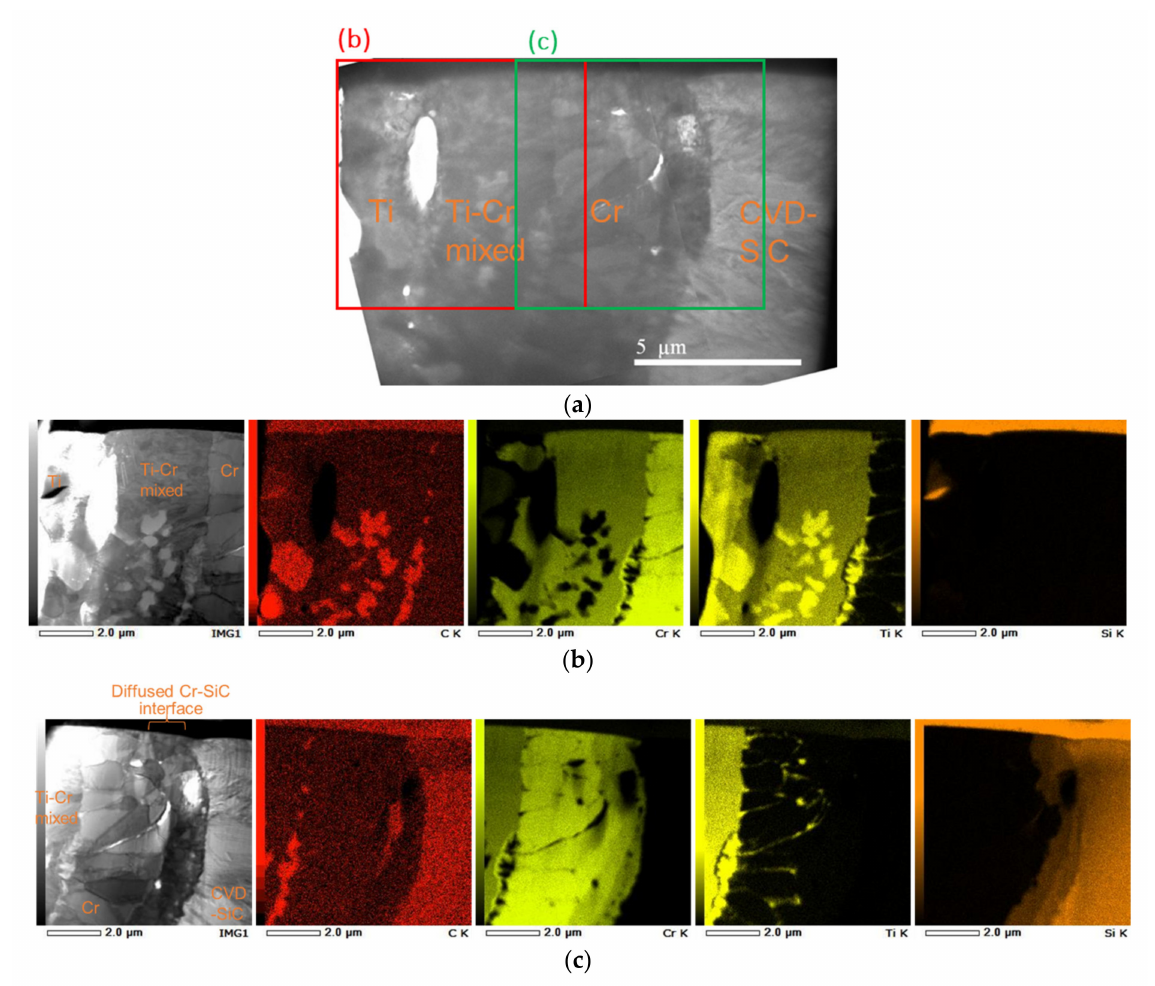
Figure 8. Cross-sectional bright field images and EDS mappings of unirradiated Ti-Cr multilayer coating. ( a ) Bright field image overview. ( b , c ) Analyzed areas described in ( a ). Far left, two bright field images, the other eight images are the EDS mappings. In ( b ) Ti, Ti-Cr mixed, and Cr layers